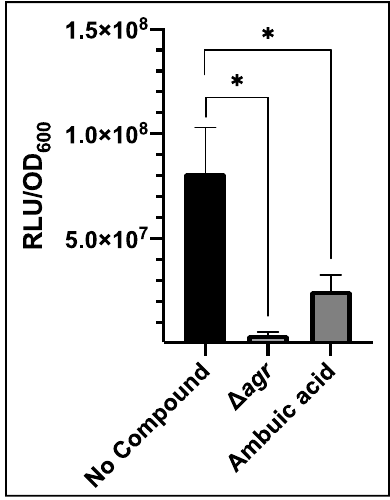
Figure 5. Impact of the AIP biosynthesis inhibitor ambuic acid (40 μ M) on bioluminescence output from S. aureus USA300 agr P3 ‐ GLuc. ‘No compound’ represents USA300 agr P3 GLuc without inhibitor, Δ agr represents USA300 Δ agr P3 ‐ GLuc without inhibitor and ambuic acid represents USA300 agr P3 GLuc with the addition of 40 μ M ambuic acid. The graph displays the mean of three technical and three biological repeats with error bars displaying standard deviation. * p < 0.01.